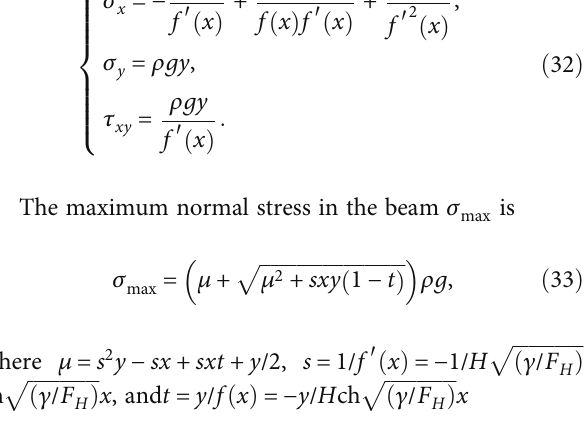
Figure 18: Stage development characteristics of arch